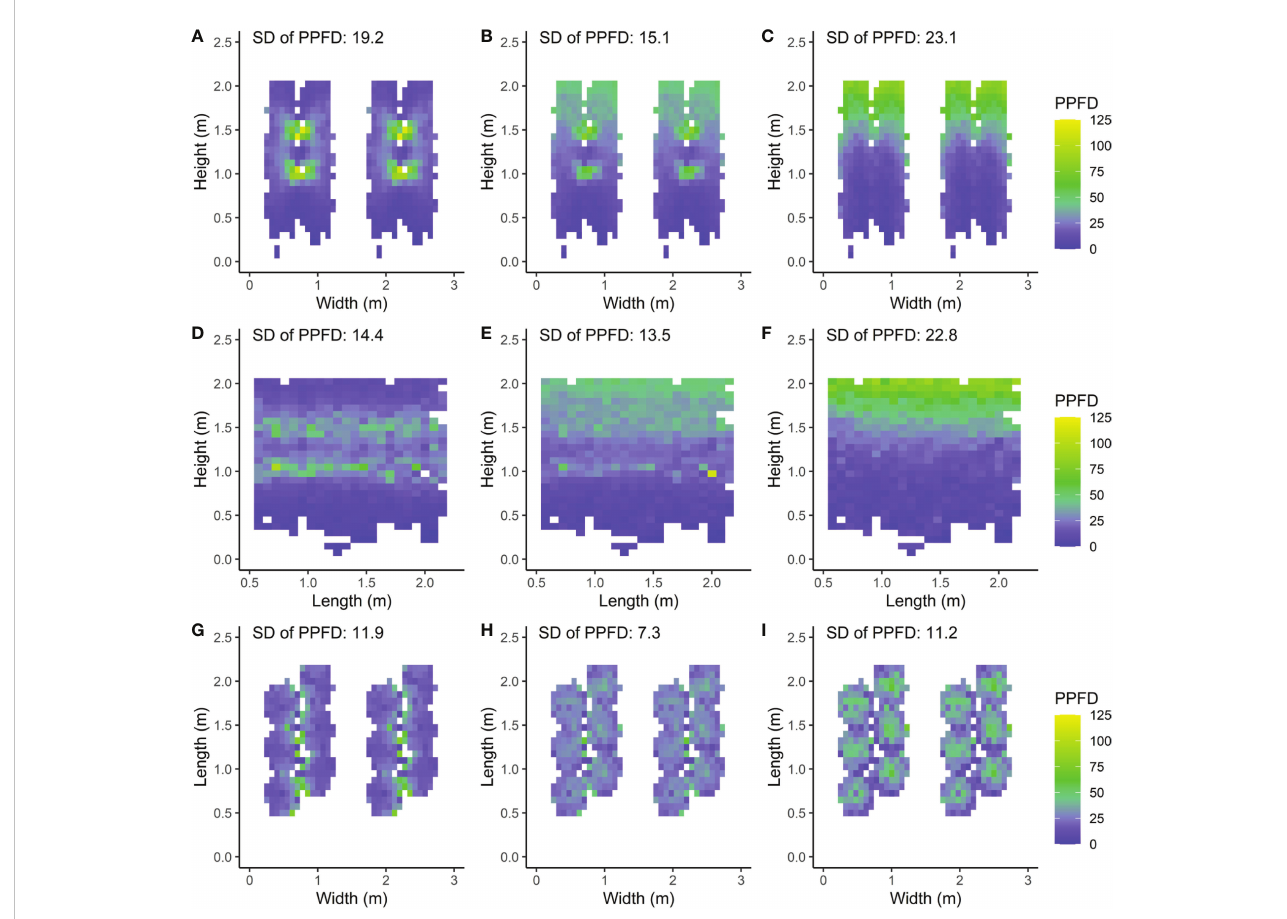
FIGURE 5 Front (A – C) , side (D – F) and top views (G – I) of a double row canopy with mean absorbed PPFD ( µ mol m − 2 s − 1 ) per voxel calculated as the mean taken from each lea fl et ’ s absorbed PPFD within the voxel. Three LED lamp positions are compared; (A, D, G) intra-canopy lighting, (B, E, H) combined intra- canopy and top lighting, and (C, F, I) top lighting. Each voxel had the dimensions of 7.5 cm width and length and a depth reaching 6 plants in each row (A – C) , 8 plants across four double rows (D – F) or whole plant height (G – I) . This means that the voxels are directed (A – C) parallel to the row; (D – F) perpendicular to the row and (G – I) vertically. The standard deviation (SD) is calculated over all voxels. Plants are spaced at 0.5m within each row in a double row. For visual interpretation of the distance between rows in the canopy an additional replicate double row is shown in A – C , G – I for which the same values were used as in the other